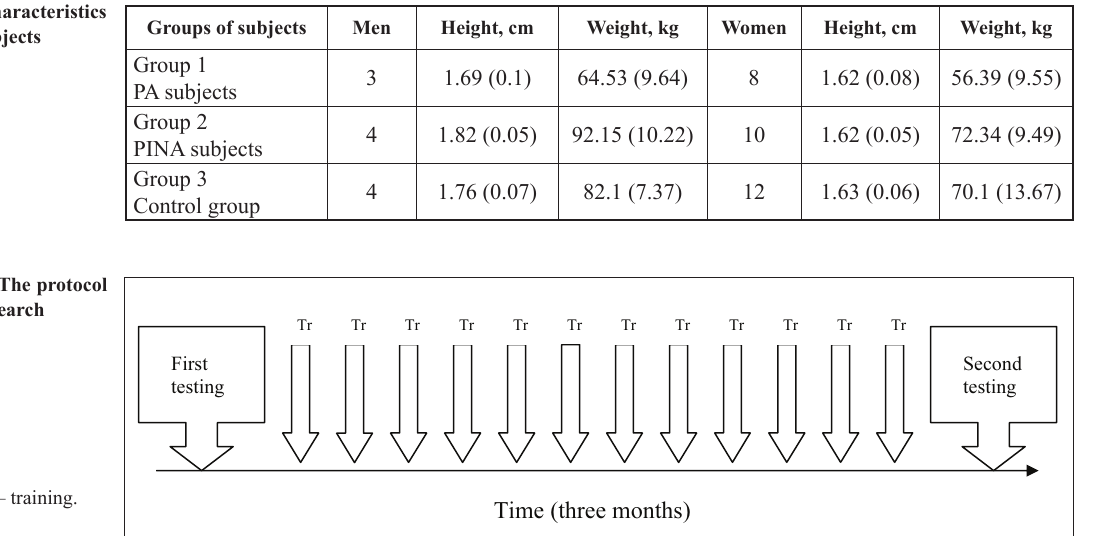
Table. Characteristics of the subjects